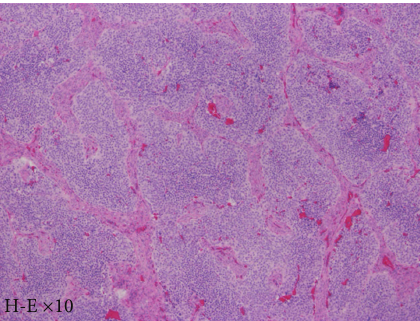
Figure 3: Pathological findings in case 1. Hematoxylin-eosin staining revealed a nest-like tumor mass under the mucosa. The tumor cells showed monotonous growth. Based on infrequent anisokaryosis and mitotic figures, the tumor was diagnosed as an ONB, Hyams’s stage I-II.